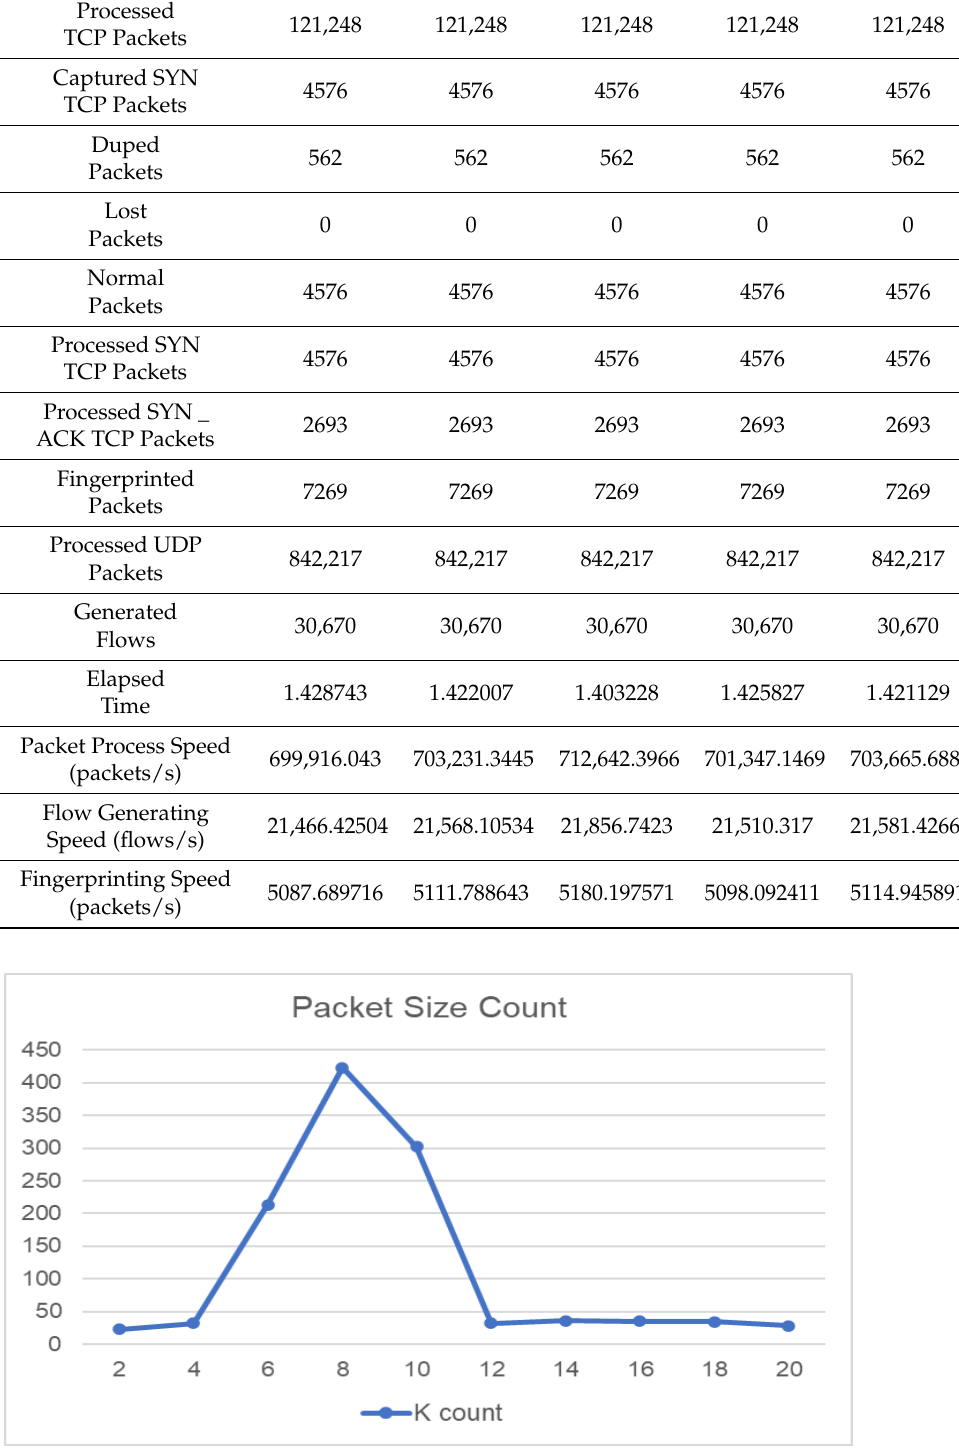
Figure 11. Packet size count of the proposed model .